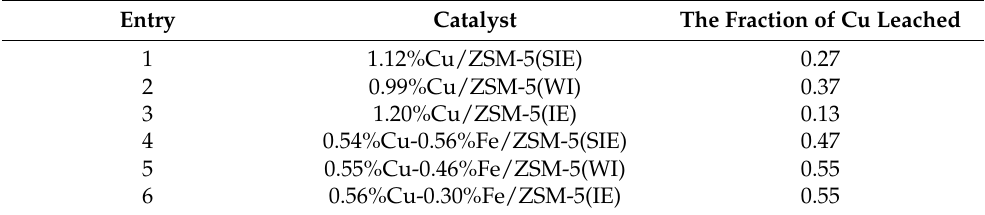
Figure 4. Partial oxidation of methane over H-ZSM-5 (a), 1.12%Cu/ZSM-5(SIE) (b), 0.99%Cu/ZSM- 5(WI) (c), 1.20%Cu/ZSM-5(IE) (d), 0.54%Cu-0.56%Fe/ZSM-5(SIE) (e), 0.55%Cu-0.46%Fe/ZSM-5(WI) (f), 0.56%Cu-0.30%Fe/ZSM-5(IE) (g), 1.13%Fe/ZSM-5(SIE) (h), 1.05%Fe/ZSM-5(WI) (i), and 0.94%Fe/ZSM-5(IE) (j). Reaction conditions: 50 mg catalyst, 31 bar methane, 0.277 M H 2 O 2 , liquid volume = 30 mL, reaction temperature = 30 °C ( A ), 50 °C ( B ). Table 2. The fraction of Cu leached after a reaction over Cu/ZSM-5 and Cu-Fe/ZSM-5 catalysts a . Entry Catalyst The Fraction of Cu Leached